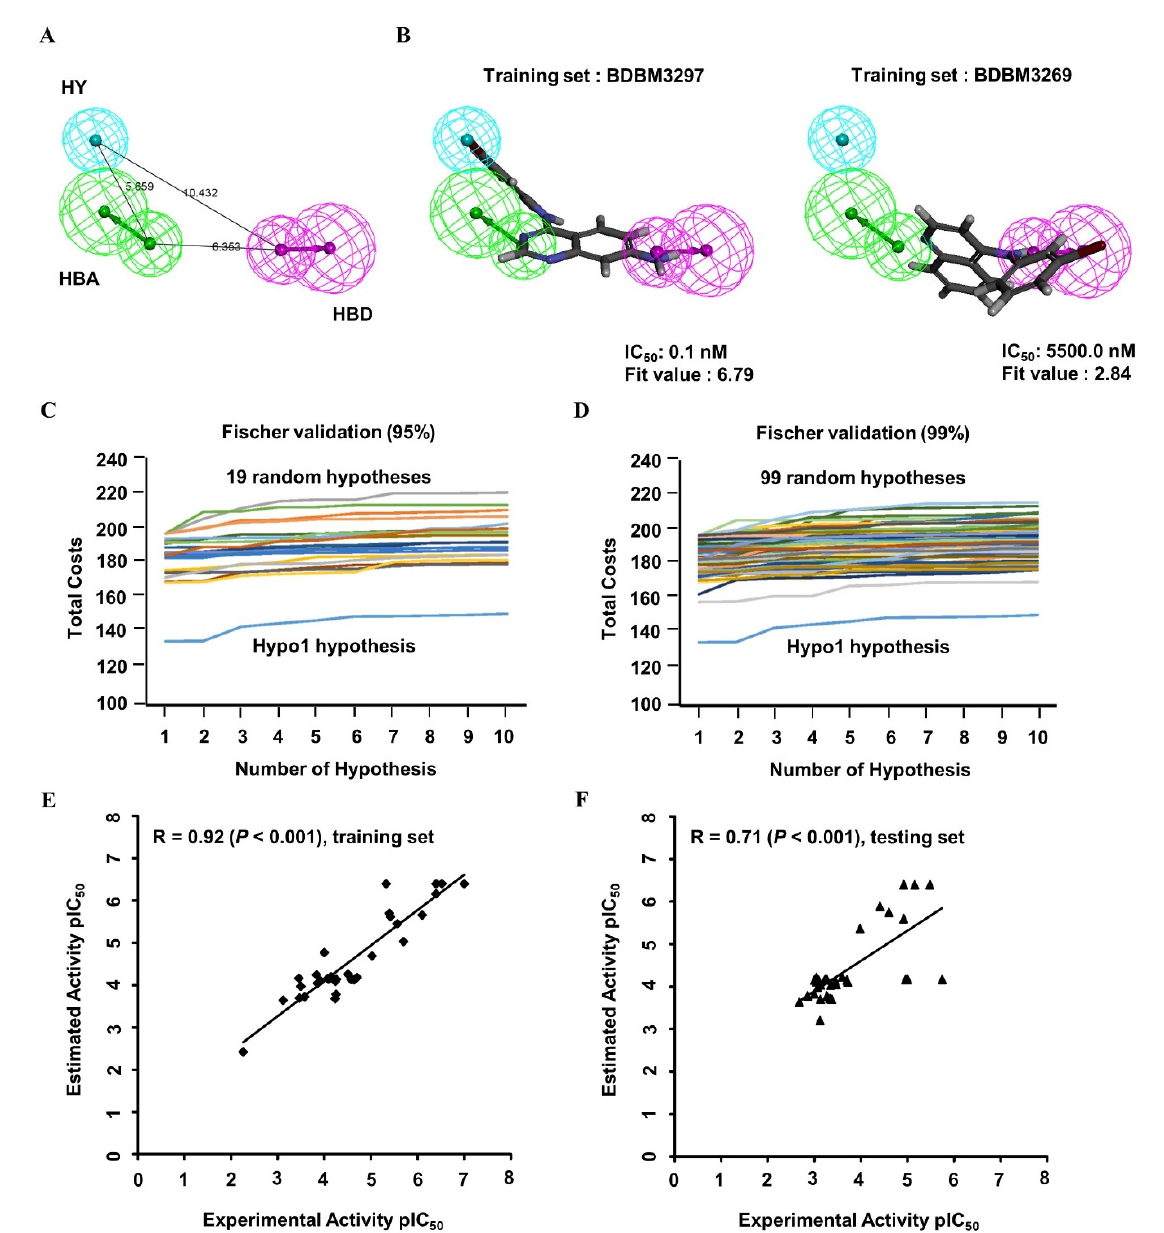
Figure 2. The 3D QSAR Hypo1 pharmacophore model of EGFR inhibitors. ( A ) Pharmacophore features of the Hypo1 model: hydrogen bond acceptor (HBA, green), hydrogen bond donor (HBD, purple), and hydrophobic region (HY, blue). The distance (Å) between every two features is shown. ( B ) The most active compound BDBM3297 (half maximum inhibitory concentration, IC 50 = 0.1 nM; fit value = 6.79) and the most inactive compound BDBM3269 (IC 50 = 5500 nM; fit value = 2.84) were mapped to the Hypo1 model. BDBM number: the general identifier of compound in the BindingDB database. ( C , D ) Validation of the statistical significance of the 3D QSAR Hypo1 model. Fischer’s randomization test was used to examine significant differences in total costs between the Hypo1 model and random pharmacophore models at a 95% confidence level ( C ) and 99% confidence level ( D ). ( E , F ) Evaluation of the predictive efficacy of the 3D QSAR Hypo1 model. Correlation plot between the experimental activity and the predicted activity of the 3D QSAR training set compounds (E; r = 0.92, p < 0.001) and test set compounds (F; r = 0.71, p < 0.001) when mapped to the Hypo1 model. The pIC 50 values of training set compounds and test set compounds were shown with the black square and the black triangle, respectively. pIC 50 : the negative logarithm value of the IC 50 value when converted to millimolar.